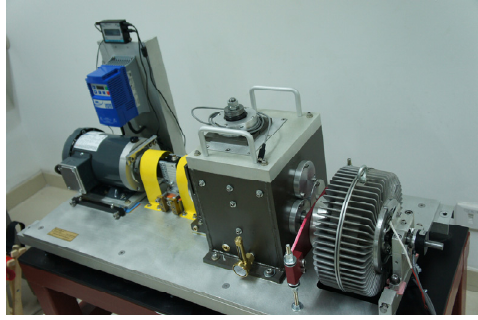
Figure 3. A bearing test rig.